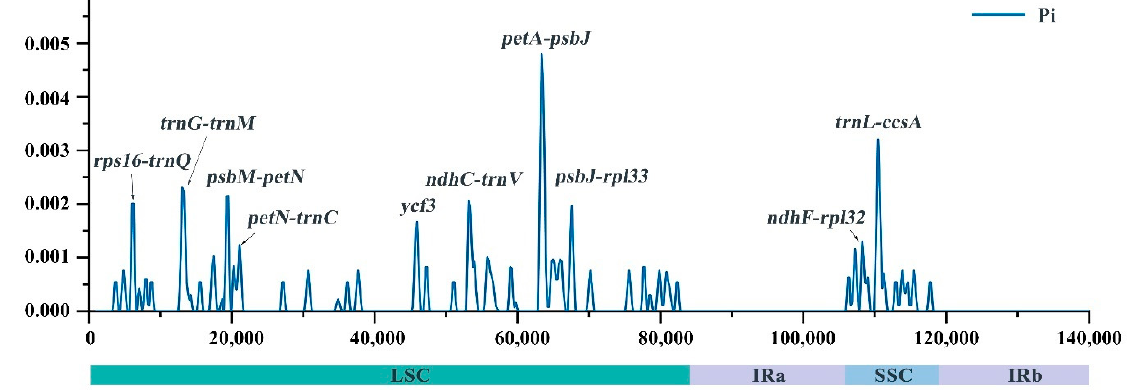
Figure 5. Nucleotide diversity (Pi) based on sliding window analysis in the aligned complete chloroplast genomes of S. spontaneum , S. officinarum , S. robustum , S. sinense , S. barberi , and S. hybrids